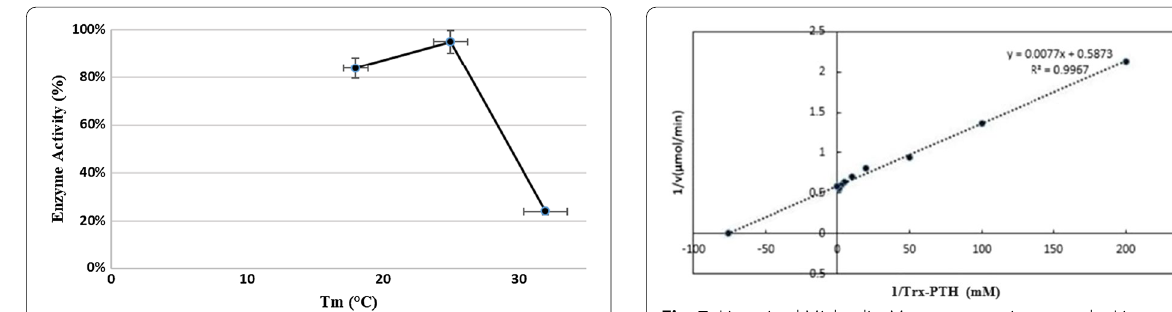
Fig. 5 Effect of induction temperature on enzyme production based on PTH peak area during enzyme bioassay. The temperature treatments had three replicates